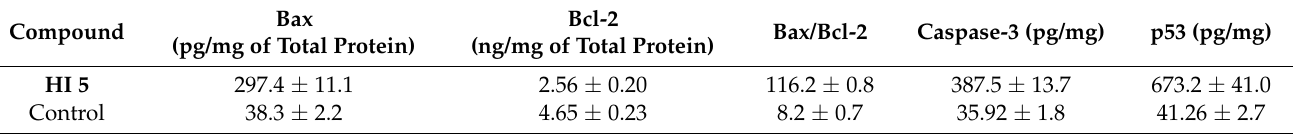
Table 4. Effect of HI 5 on the expression levels of Bcl-2, Bax, active caspase-3, and p53 in MCF-7 cancer cells. Compound